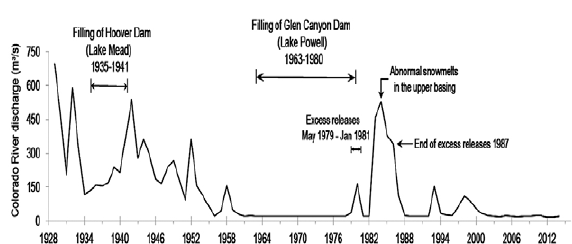
Fig. 5. – Historical record of the Colorado River discharge. Data from Yuma (Arizona, USA) for the period 1904 to 1949 and from the Morelos Dam (Mexico) for the period 1950 to 1998. (Source: Lavín and Sánchez